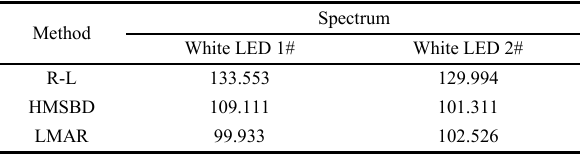
Fig. 12 Correction errors of all three methods for processing white LED 2# spectrum. Table 1 RMSE of all three methods.